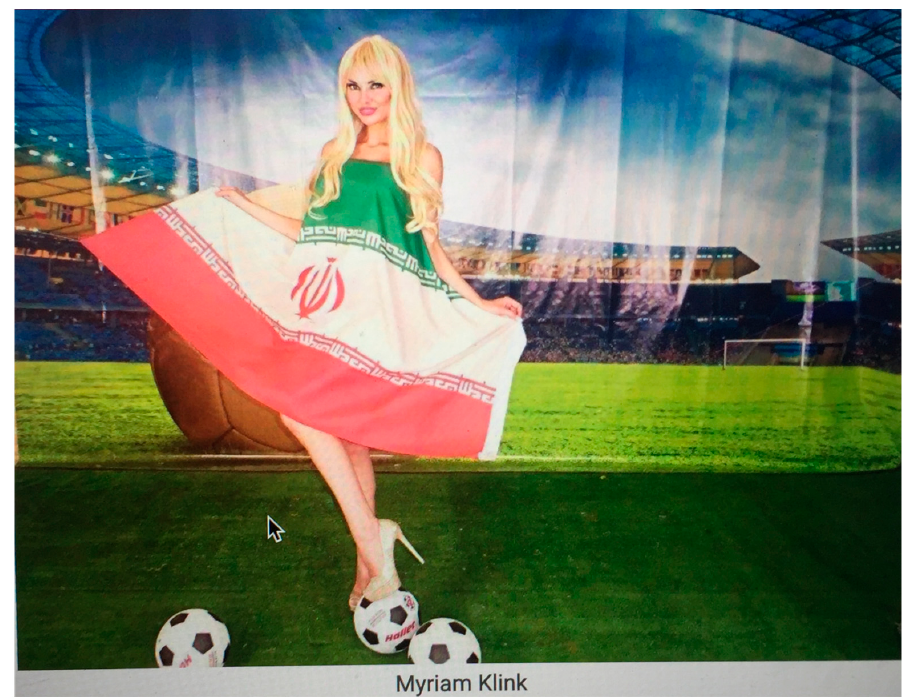
Figure 13. “Lebanese model supports Iran in World Cup.” Myriam Klink body wrapped in Iranian National Flag -during the World Cup 2014 showing her support for Teme Meli football of Iran. Source: https://features.kodoom.com/en/entertainment/lebanese-model-supports-iran-in-world-cup/v/5427/ .